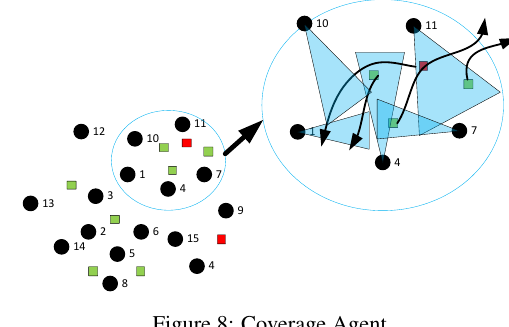
Figure 8: Coverage